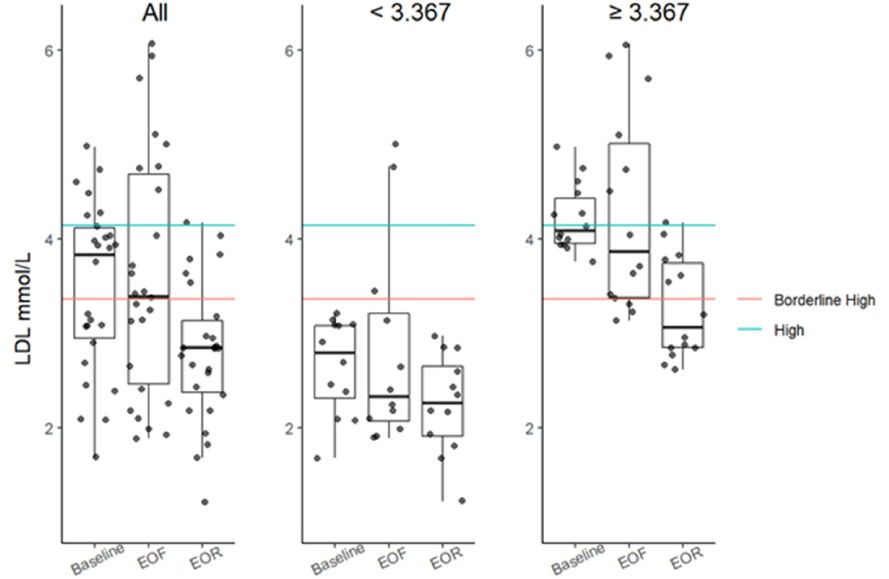
Figure 5. Serum LDL boxplots at baseline, EOF, and EOR. Data further categorized based on the high LDL threshold ( ≥ 3.367 mmol/L; red line). LDL between 3.367 and 4.1181 mmol/L is considered borderline high. LDL between 4.144 mmol/L (blue line) and 4.8951 mmol/L is considered high. Boxplots represent the minimum non-outlier value (lower whisker) whiskers, the first quartile (lowest point of the box), the median (horizontal line inside the box), the third quartile (highest point of the box), and the maximum non-outlier value (upper whisker). Data points that extend past the whiskers are outliers. EOF, end of fast; EOR, end of refeed; LDL, serum low-density lipoprotein; mmol, millimole; L, liter.